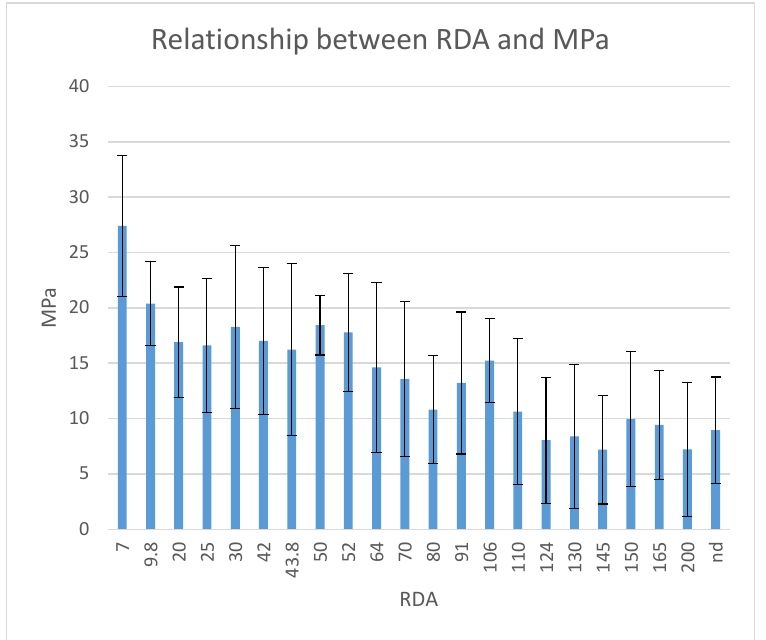
Figure 1. In vitro SBS values (in MPa) for each agent tested. Table 5. RDA and ARI